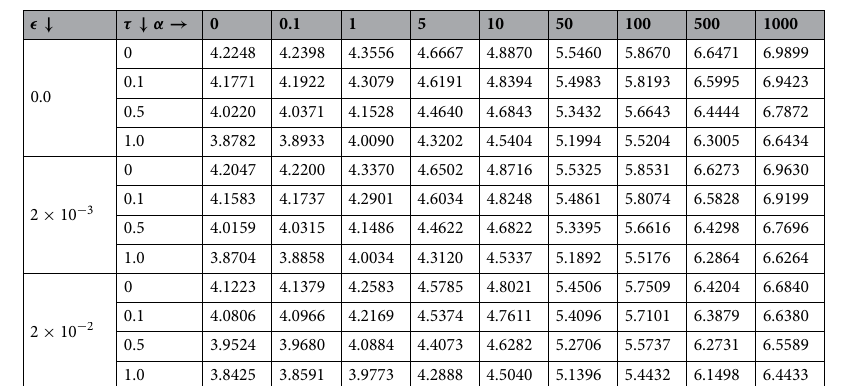
Figure 7. Spatial distribution of the positive space charge I and some values for the ionization rate ǫ .